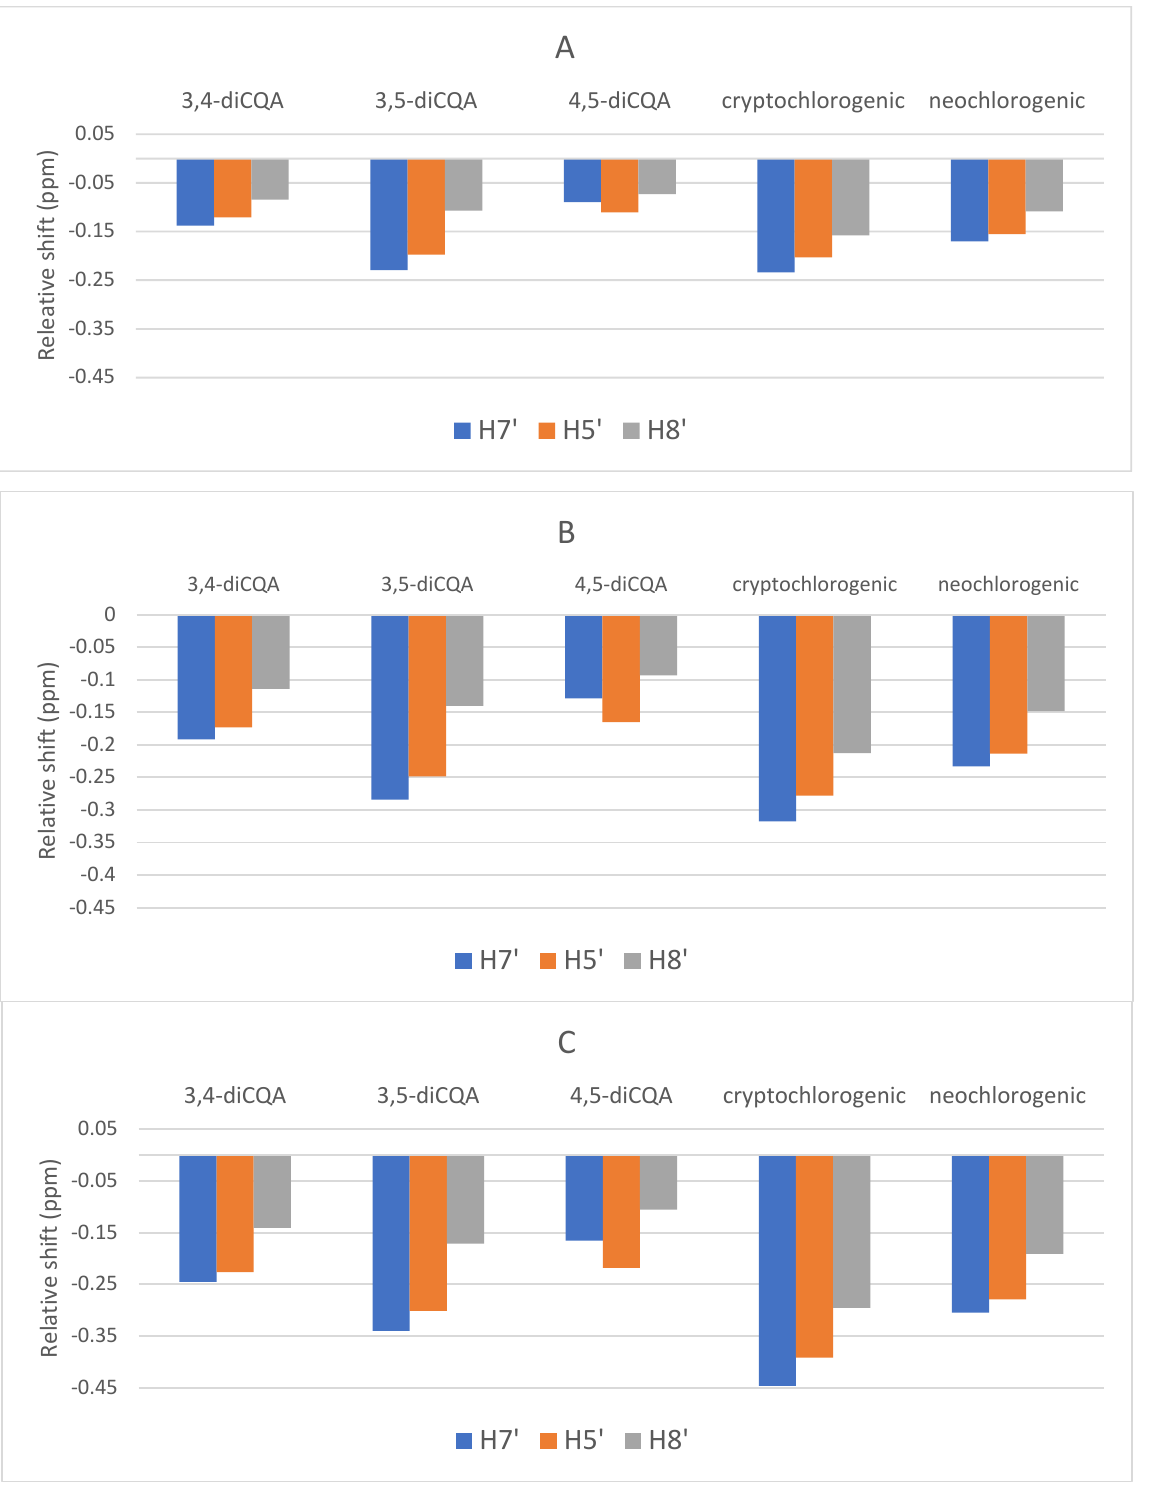
Figure 8. Relative complexation shifts of CQA caffeoyl 1 H NMR signals with sequential addition of pure caffeine to CQA solutions; 3,4 − diCQA (3.4 mM), 3,5 − diCQA (4.9 mM), 4,5 − diCQA (3.3 mM), crypto chlorogenic acid, 4 − CQA (9.8 mM) and neochlorogenic acid, 5 − CQA (5.8 mM). ( A ) 9 mM caffeine ( B ) 27 mM caffeine, and ( C ) 54 mM caffeine.